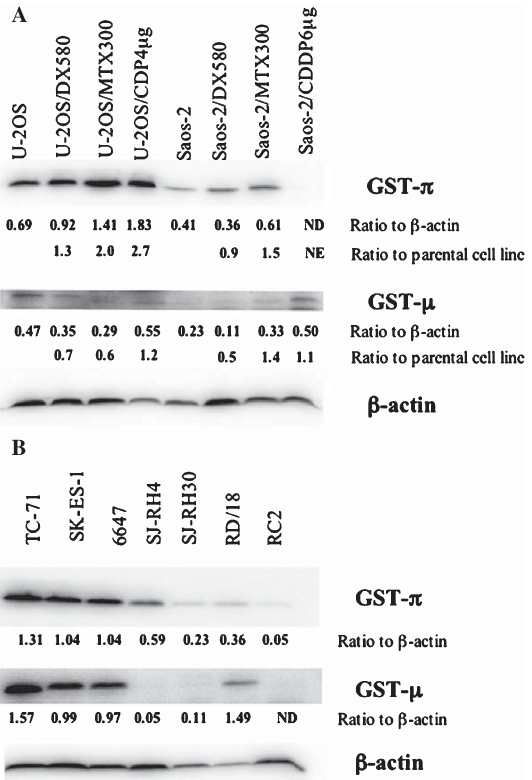
Fig. 2. Intracellular levels of glutathione-S transferase (GST) pro- teins in the panel of osteosarcoma (panel A), Ewing’s sarcoma and rhabdomyosarcoma cell lines (panel B), assessed by western blot. The amount of GST proteins of each cell line was determined by densitometric analysis and normalised to that of ß-actin. For drug resistant variants, each normalised GST protein level was related to that of the corresponding parental cell line. Figure shows data of one representative experiment. ND, not detectable; NE, not